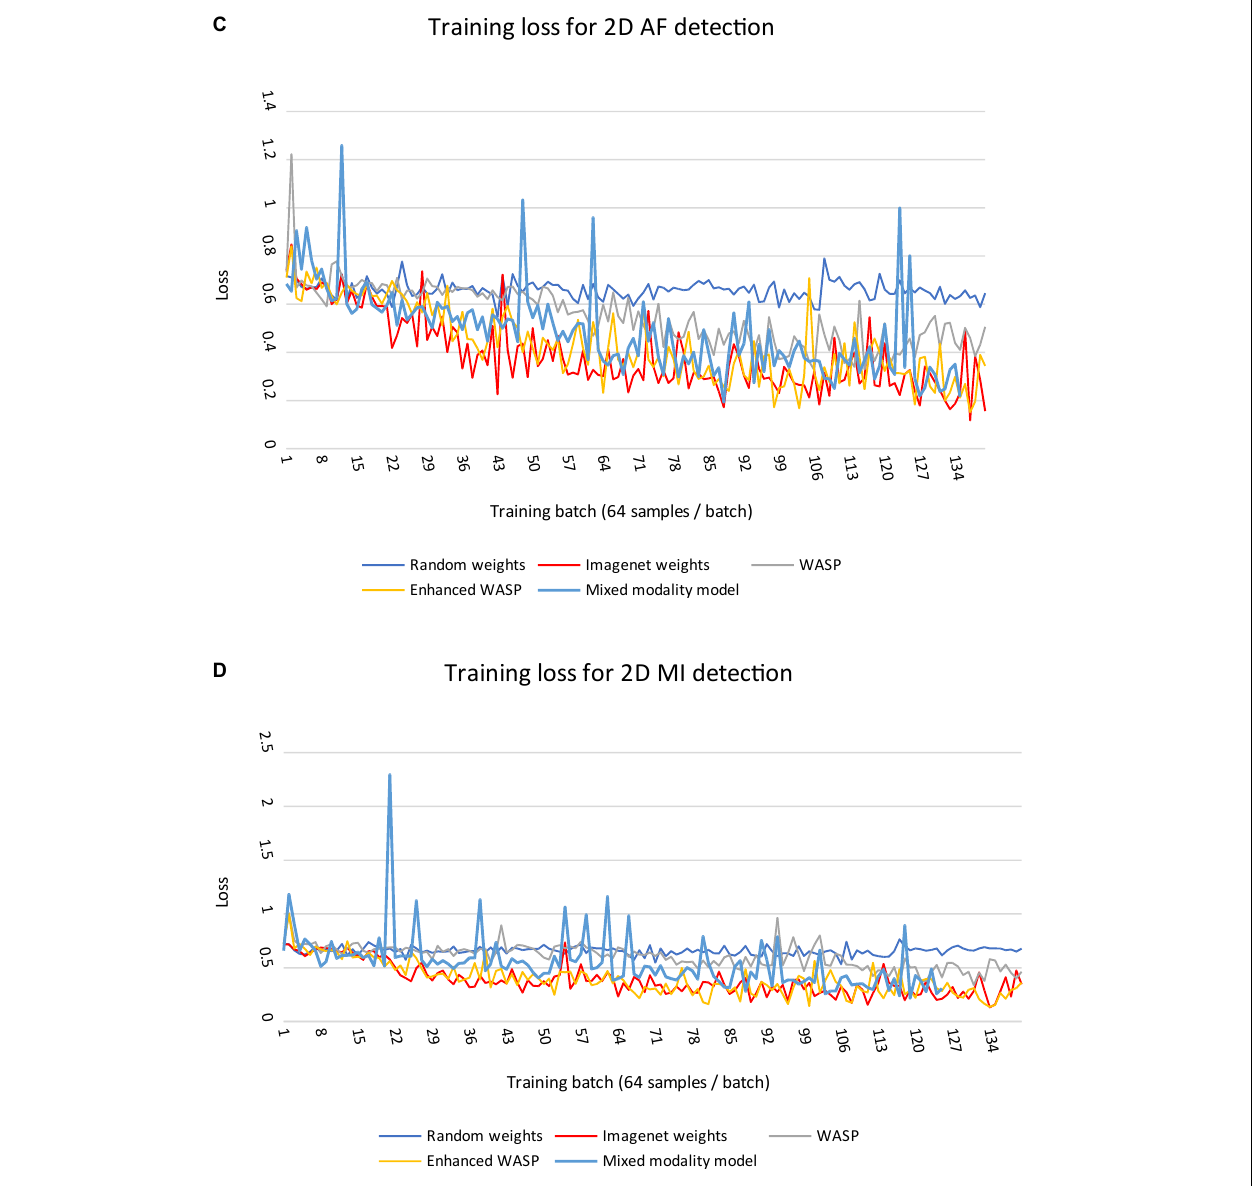
FIGURE 6 | (A,B) Training losses for 1D models on diagnostic classification tasks with PTB ECGs. Each training run comprised a single epoch. WASP, WaSP. (C,D) Training losses for 2D models on diagnostic classification tasks with PTB ECGs.